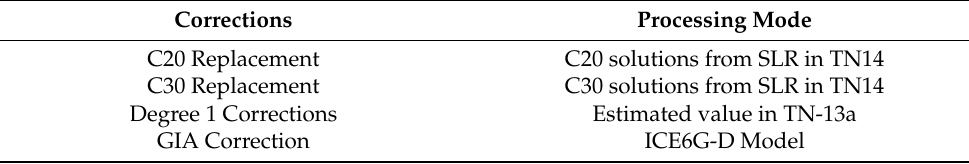
Table 3. The main corrections used in Mascon